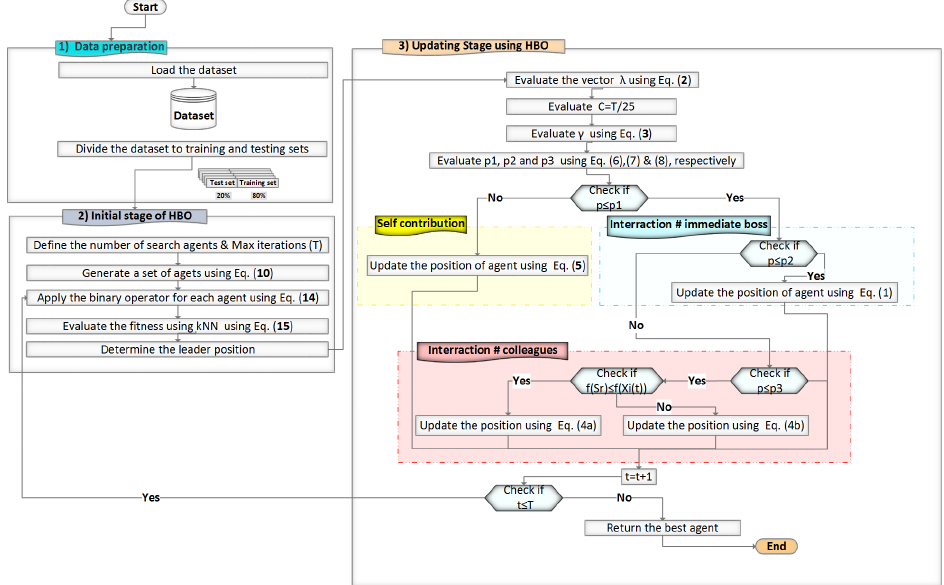
Figure 1. The framework of the proposed B _ HBO for feature selection based on KNN